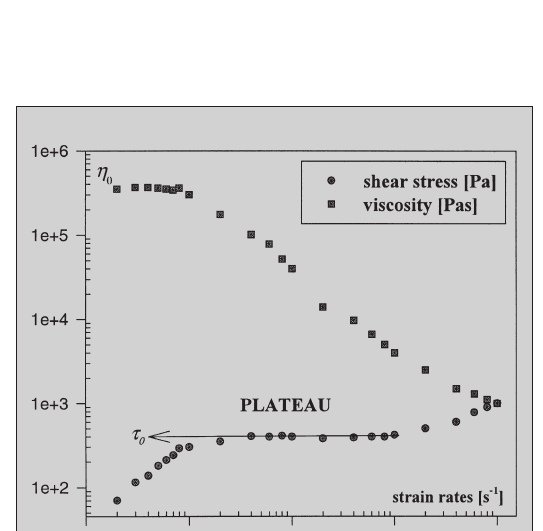
Figure 2 (right): Strain and the strain rate evolution in the creep experiments of “soft solids”. The secondary creep is asso- ciated with the steady shear flow (lubricating grease; cone and plate